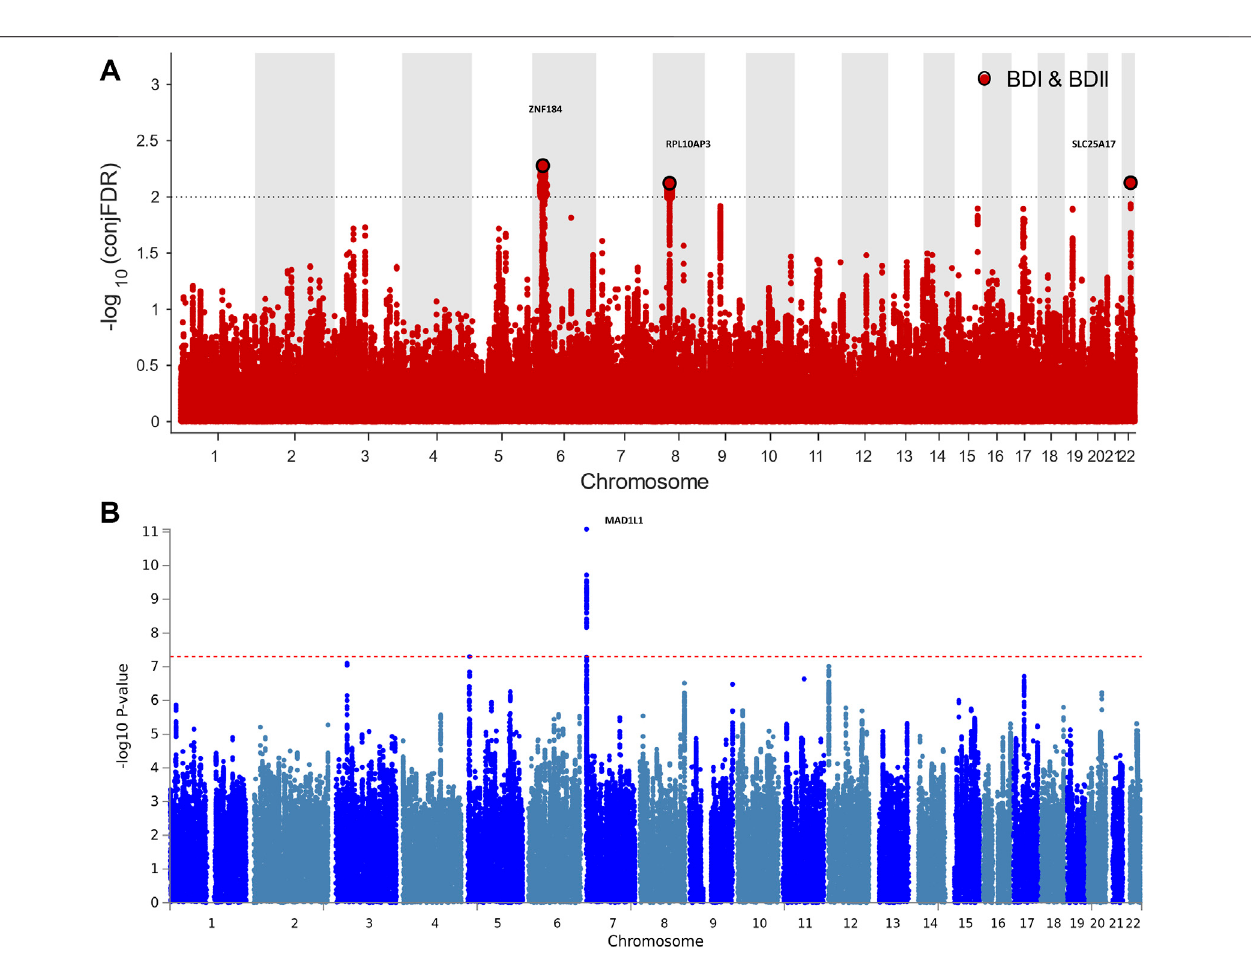
FIGURE 2 | Manhattan plots showing the association statistics for single marker analysis of BD I and II genetic overlap ( Figure 2A ) and distinctness ( Figure 2B ). The y -axis shows the GWAS − log10 p -values per SNP across chromosomes 1-22. (A) SNPs with conditional p -value < 1 × 10 − 2 are shown with large black points. (B) SNPs identi fi edbycase – casegenome-wide associationanalysis(CC-GWAS) with p < 5×10 − 8 .The fi guresshowthelocalizationofsigni fi cantloci.Detailsabouttheloci are provided in Tables 1 and 2